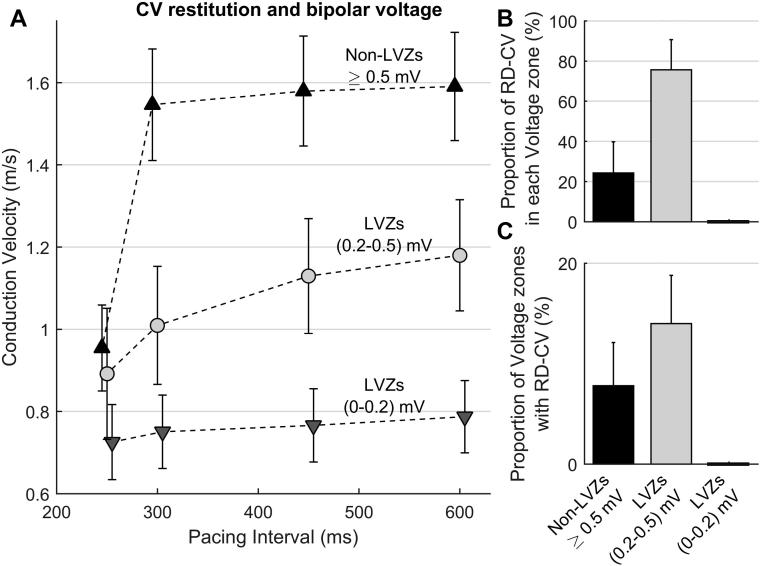
A: Change in CV over the 4 pacing intervals in non-LVZs ≥0.5 mV (black triangles), LVZs (0.2–0.5 mV) (light gray circles), and LVZs (0–0.2 mV) (dark gray triangles). B, C: Bar chart showing the percentage of rate-dependent CV slowing sites in non-LVZs ≥0.5 mV, LVZs (0.2–0.5 mV), and LVZs (0–0.2 mV) (B) and the proportion of non-LVZs ≥0.5 mV, LVZs (0.2–0.5 mV), and LVZs (0–0.2 mV) demonstrating rate-dependent CV slowing (C). CV = conduction velocity; LVZ = low-voltage zone; RD-CV = rate-dependent conduction velocity.